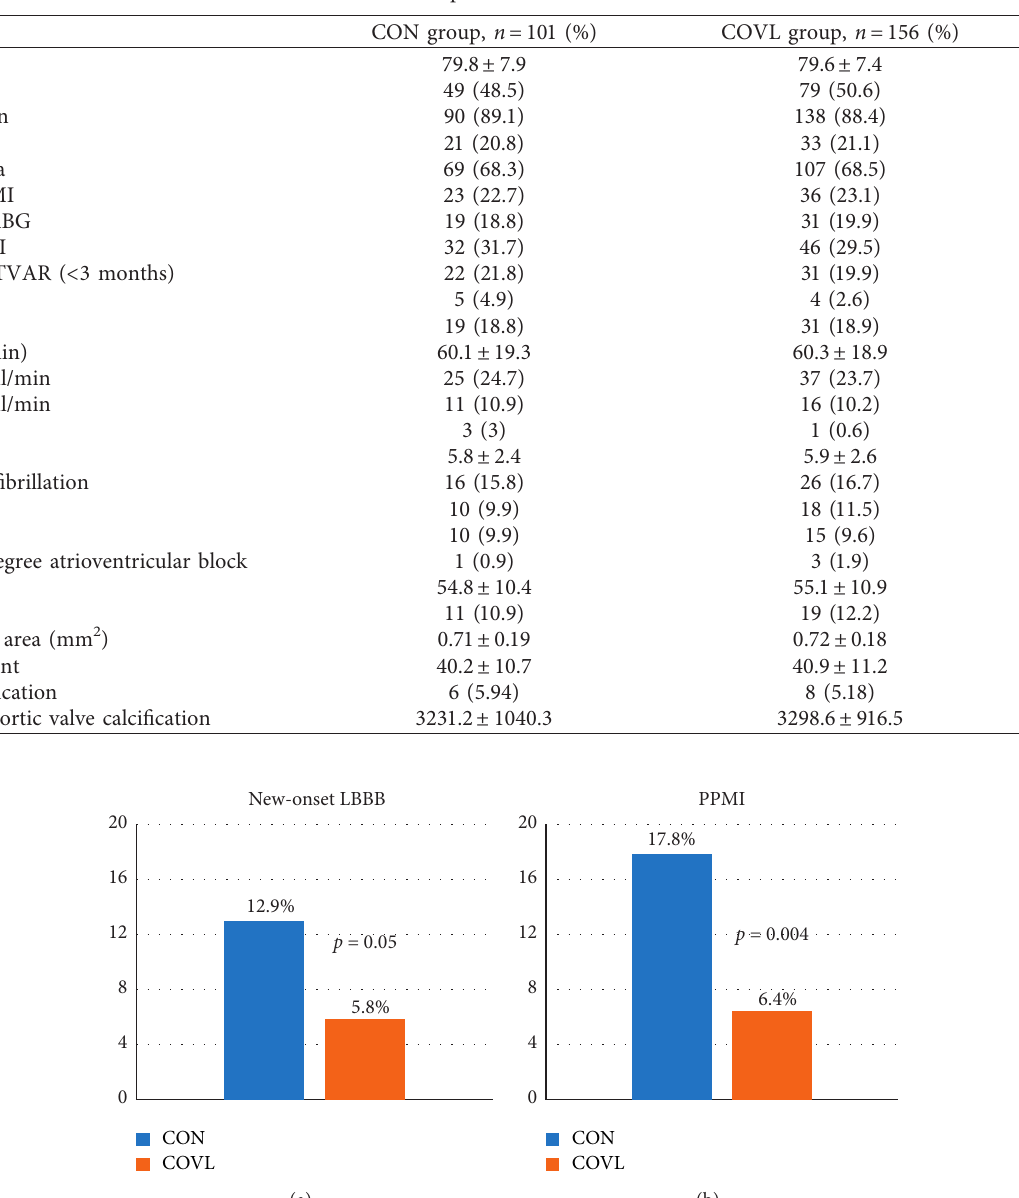
Table 1: Population characteristics.